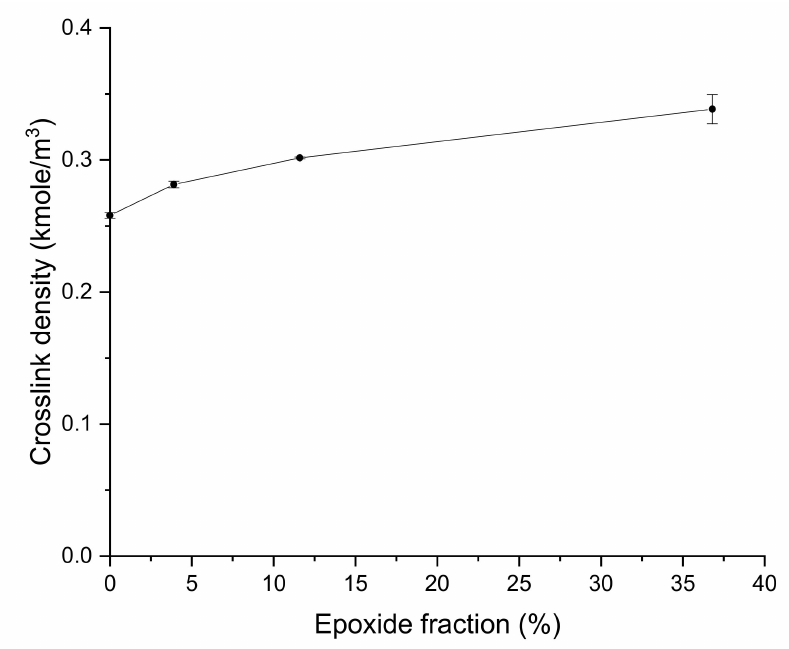
Figure 4. Crosslink density of guayule natural rubber/epoxidized guayule natural rubber blend composites at various epoxide fractions. Table 4. Volume fraction of the rubber network in the swollen phase, crosslinks density of